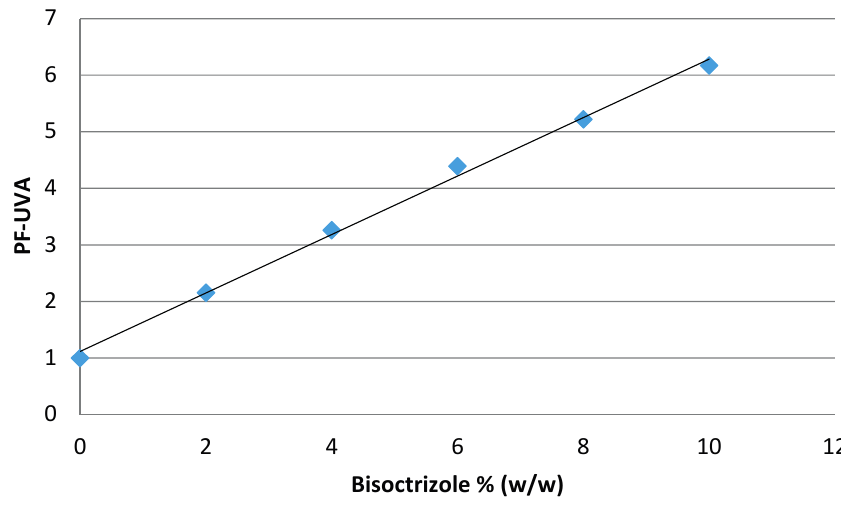
Figure 2. Efficacy of bisoctrizole in the UVA